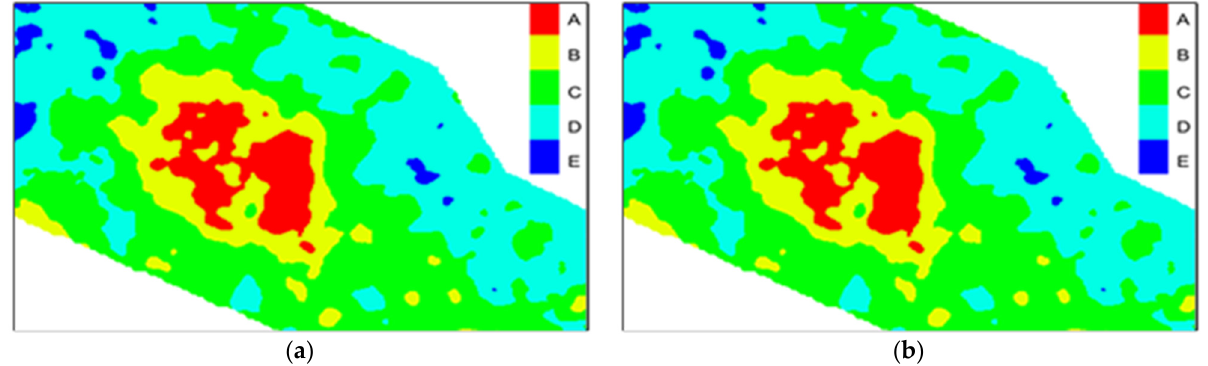
Figure 9. Superposition results from different types of ( a ) geological sweet spots and ( b ) engineering sweet spots.